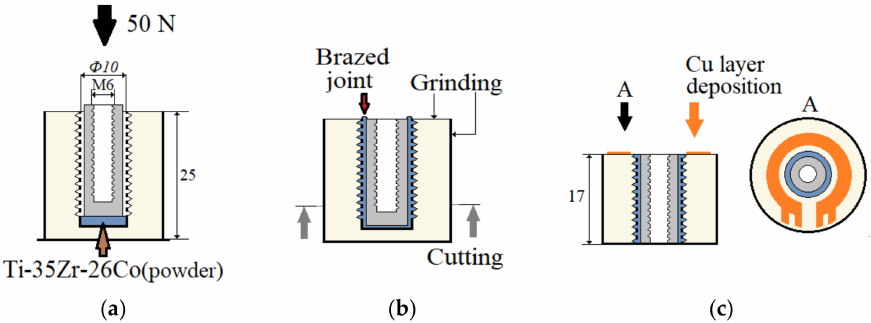
Figure 4. Alumina/titanium brazing and processing cycle of a milled and sputtered sample: ( a ) brazing; ( b ) post-processing; ( c ) spraying contacts.